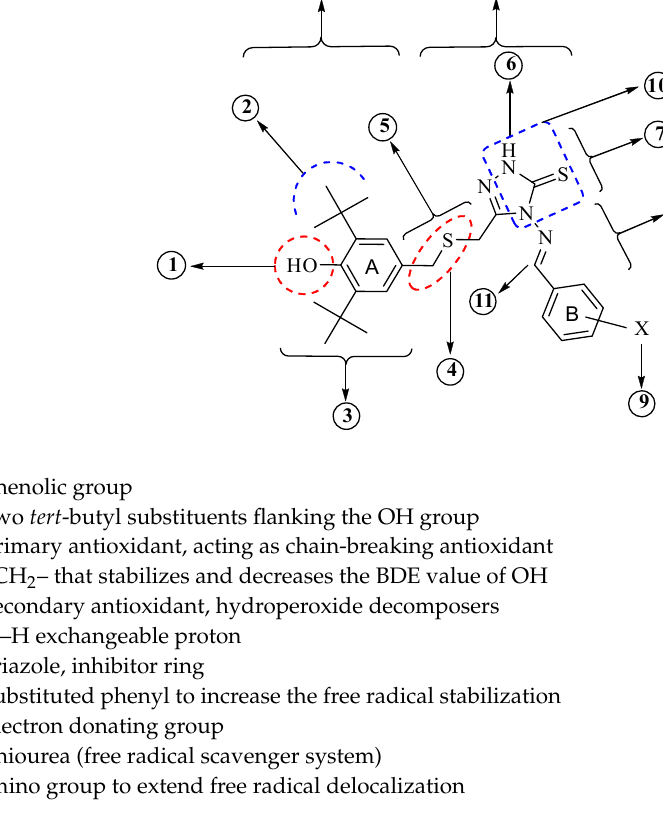
Figure 1. Rational design of Schiff base-1,2,4-triazoles bearing BHT moieties.